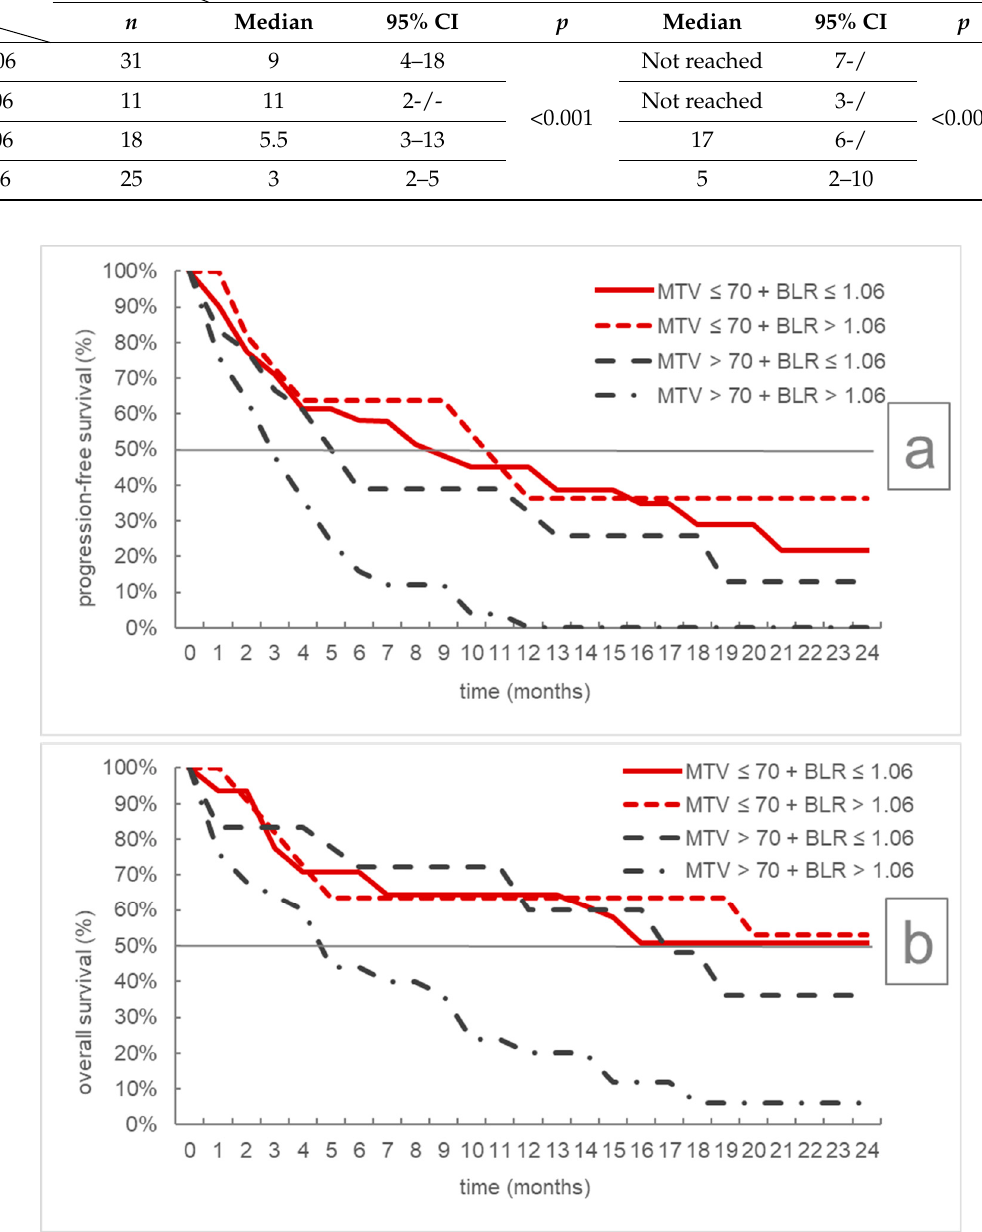
Table 5. Median progression-free and overall survival according to combined MTV and BLR subgroups values. CI = confidence interval, MTV = metabolic tumor volume, BLR = bone marrow to liver ratio. Progression-Free Survival Overall Survival